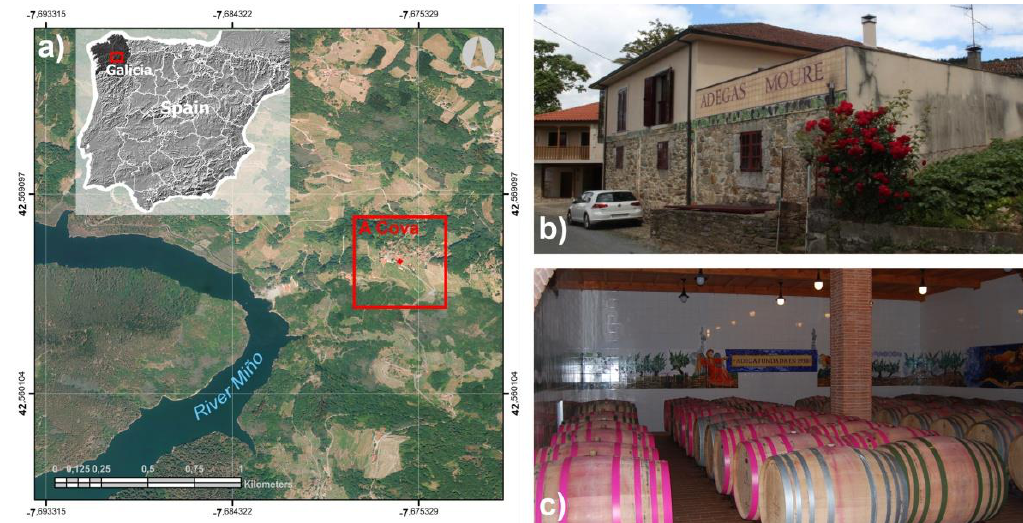
Figure 1. ( a ) Location of the study building (A Cova, Lugo) and images of the cellar from ( b ) outside (main façade) and ( c ) inside the wine-ageing room (ground floor).